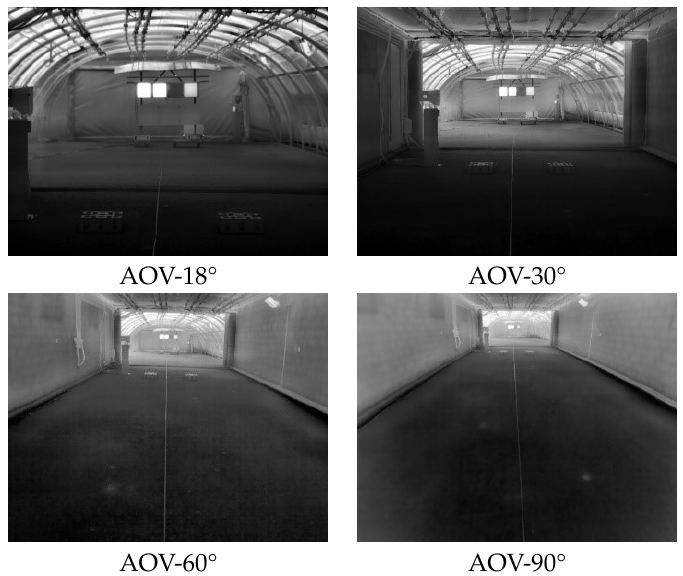
Figure 4. Images from the four cameras used during the tests. The AOVs were: 18°, 30°, 60°, and